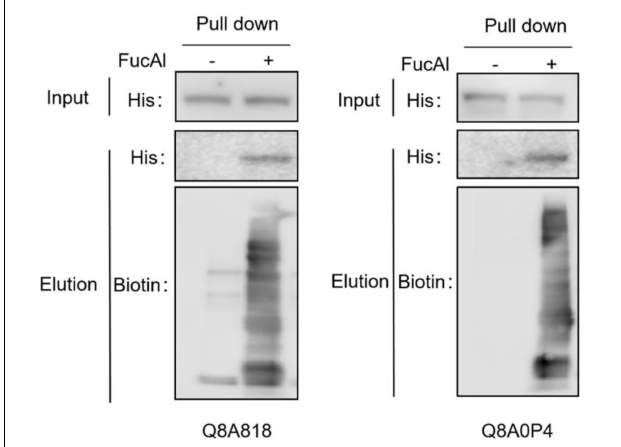
FIGURE 4 | Fucosylation verification of two candidate FGPs. The cell lysates were prepared and reacted with biotin-picolyl-azide via CuAAC, followed by streptavidin beads pull-down. The enriched proteins were analyzed by Western blot with anti-His and anti-biotin